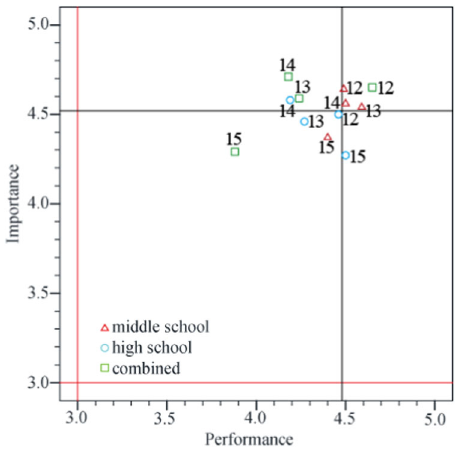
Fig. 4 IPA values of “ the perception of STEM-ED itself ” in the different age groups taught. The performance scores (green squares) of the combined group of teachers were all located